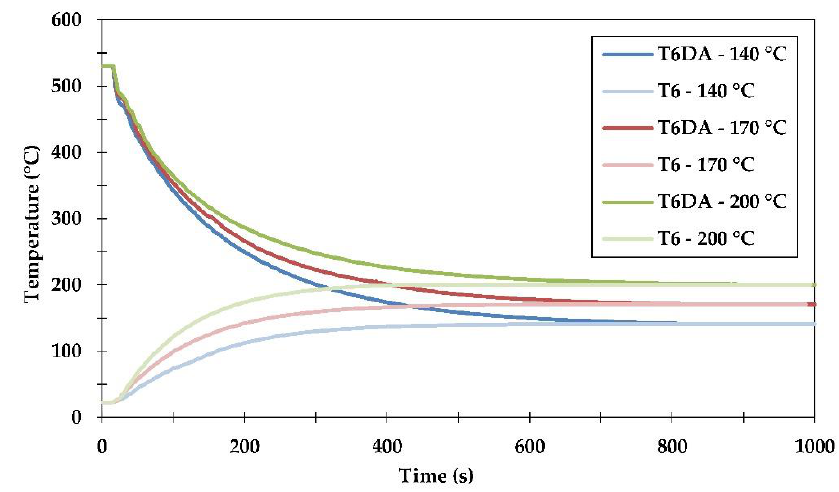
Figure 4. Temperature evolution measured during alloy quenching from a solutionizing temperature of 530 °C directly to artificial ageing temperatures of 140 °C, 170 °C and 200 °C (T6DA procedure), as well as during heating to artificial ageing temperatures from room temperature (T6 temper procedure).